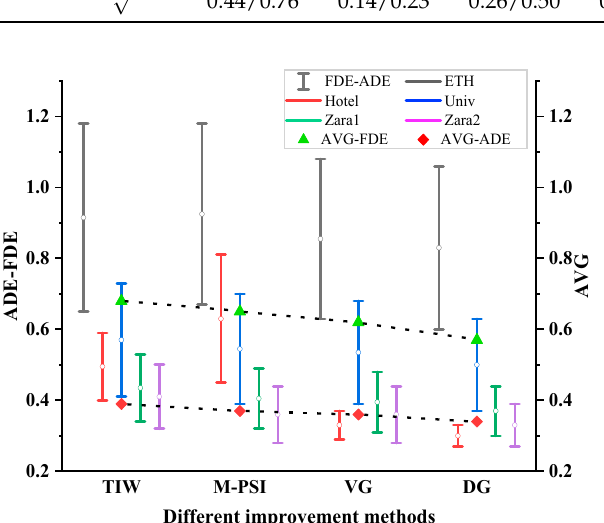
Figure 8. The effects of different improvement methods on five scenarios included in the datasets ETH and UCY, where the upper end of “I” denotes FDE and the lower end denotes ADE, and in the figure, different improvement methods are stacked in sequence. Table 3. The results of ADE/FDE obtained through ablation experiments.